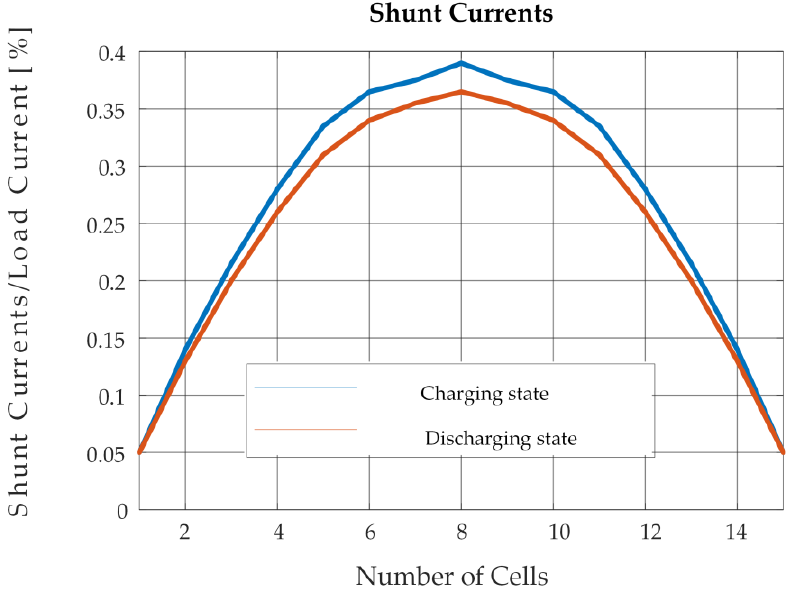
Figure 4. Shunt currents during charging and discharging states.